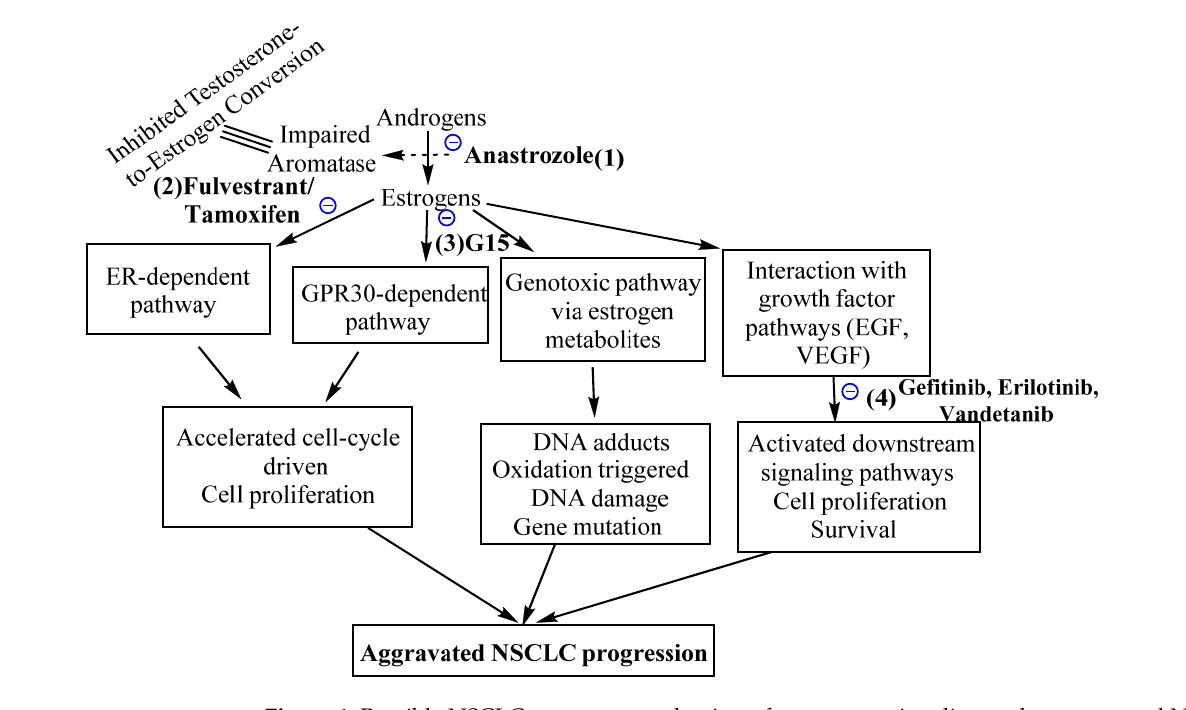
Figure 4. Possible NSCLC treatment mechanisms for estrogen signaling pathway targeted NSCLC treatment, comprising (1) aromatase suppression using the inhibitor anastrozole, (2) impaired activity of ERs using pure anti-estrogen fulvestrant, (3) impaired GPR30-driven signaling via antagonist G15 and (4) targeting the estrogen-activated growth factor pathways, mainly EGF and VEGF, using gefitinib, erlotinib and vandetanib drugs. These strategies can be used in singular as well as in combination mode.